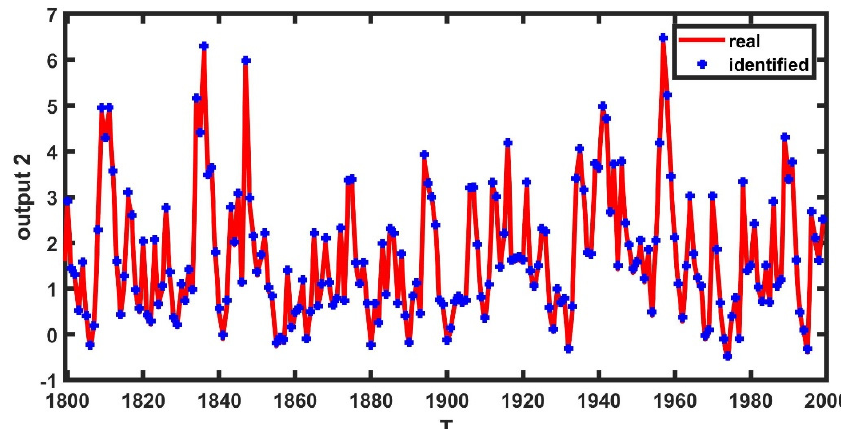
Figure 10. The real output 2 and the identified output 2.